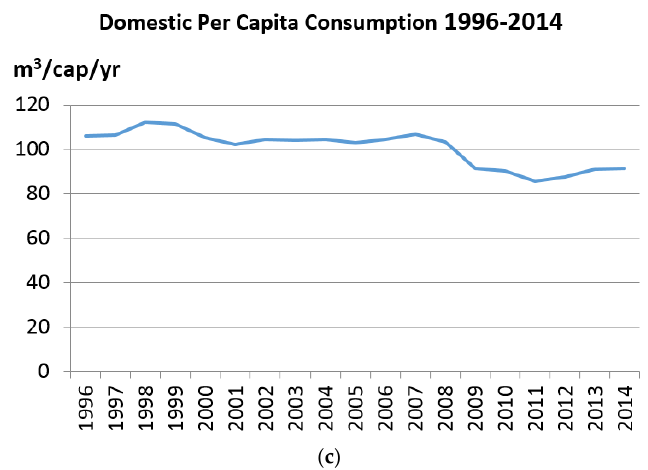
Figure 2. ( a ) total water consumption 1996–2014; ( b ) freshwater consumption 1996–2014; ( c ) domestic per capita water consumption 1996–2014. Based on data from